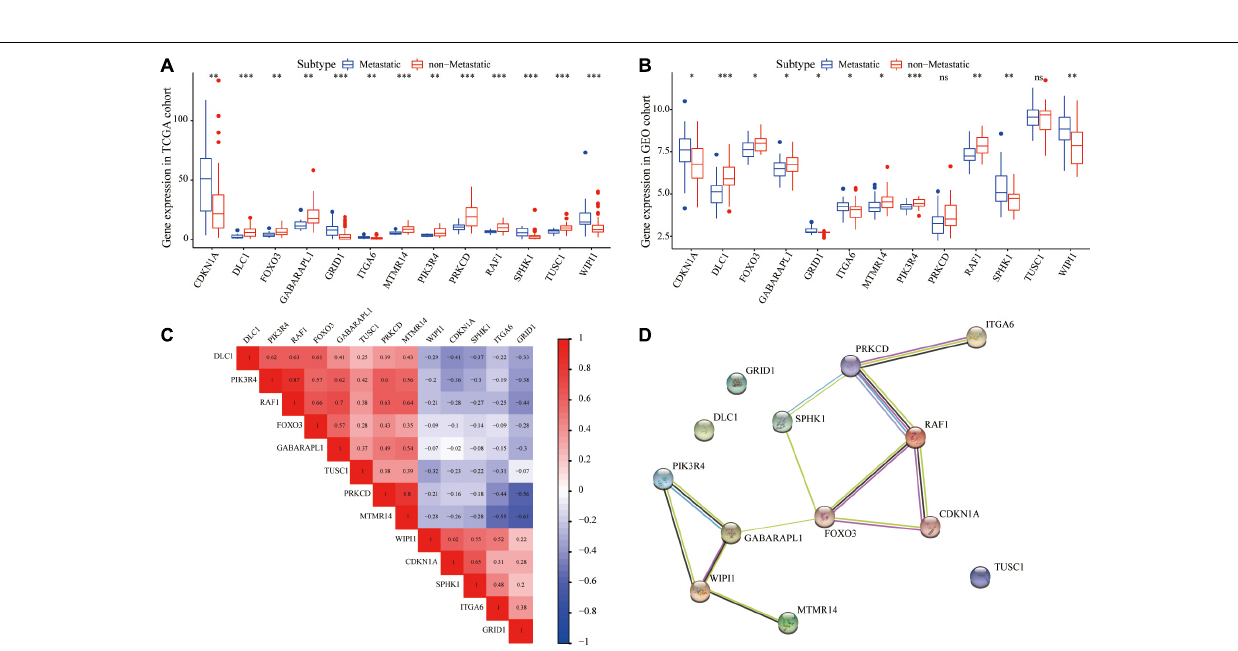
FIGURE 3 | Validation and correlation analysis of autophagy DEGs. (A) Box plot of the expression of the autophagy DEGs between metastatic and non-metastatic UM in TCGA cohort. (B) Box plot of the expression of the autophagy DEGs between metastatic and non-metastatic UM in the GEO cohort. (C) Correlation analysis diagram of autophagy DEGs. (D) Protein–protein interaction network of autophagy DEGs. * P < 0.05, ** P < 0.01, *** P <